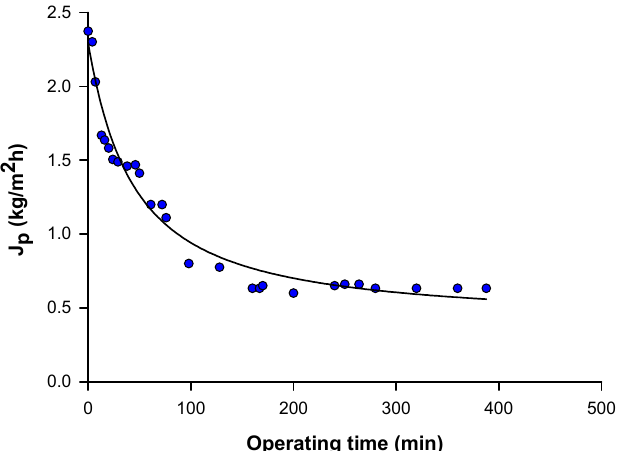
Figure 4. Reverse osmosis of nanofiltered olive mill wastewaters. Time course of permeate flux (transmembrane pressure, 16 bar; temperature, 25 ± 1 °C).